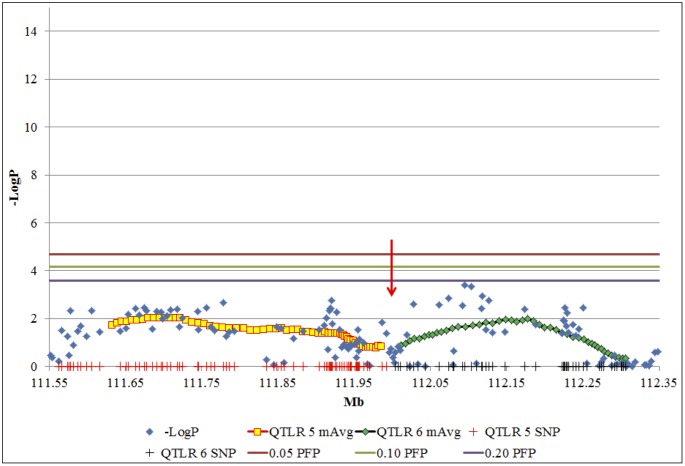
Example of a region with two mapped QTLRs that are possibly only one putative QTLR.QTLRs 5 and 6 on BTA 2. Red and black vertical bars on the X-axis, QTLRs 5 and 6 marker locations; Blue diamonds, -LogP values of the markers; Yellow squares (QTLR 5) and green diamonds (QTLR 6): X-axis, mean location of the markers in the window; Y-axis, mean -LogP of the window; red arrow, inter QTLR cluster. Three uppermost horizontal bars from top down: significance thresholds for individual markers at PFP = 0.05, 0.10 and 0.20, respectively.